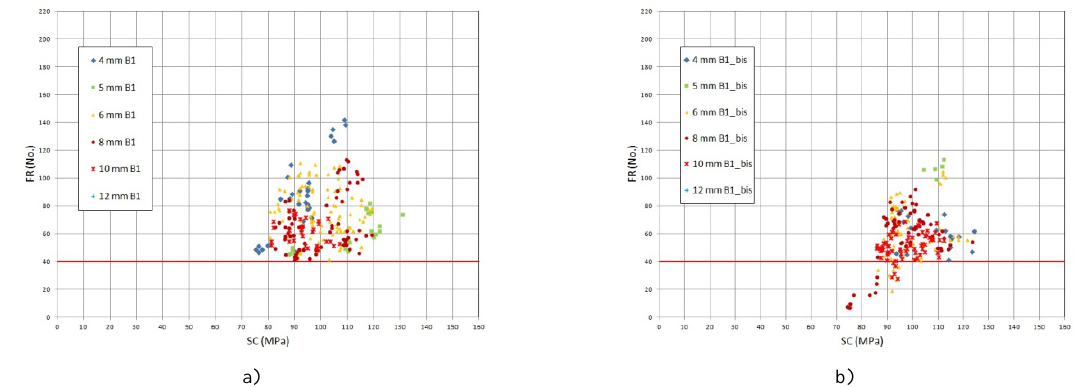
Fig. 2 Correlation of surface compressive stress (SC) versus fragmentation (FR): a) for B1 coated glass; b) for B1_bis coated glass